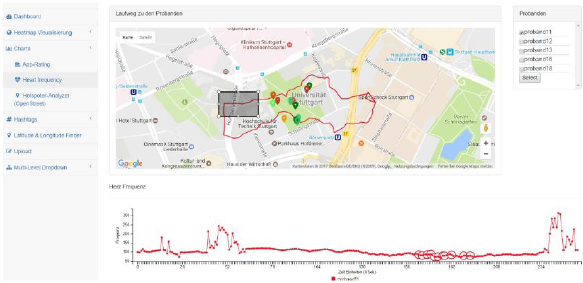
Figure 3. Screenshot of visualization tool